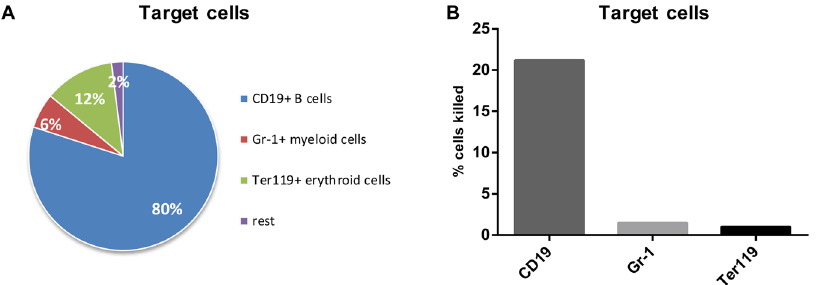
Figure 5. CD4 + T cell cytotoxicity against MHC II + target cells. Target cells for the CD4 + T cell cytotoxicity assay were obtained from lymph nodes and spleens of naïve mice, loaded with epitope peptides and injected into FV-infected recipient mice. The target cell population was depleted for T cells to increase the frequency of possible MHC II + targets. ( A ) Distribution of different target cell populations in the lymph nodes of naïve recipient mice. ( B ) Frequencies of killed cells indicated that CD19 + B cells were the main targets of cytotoxic CD4 + T cells. The data were pooled from two independent experiments with similar